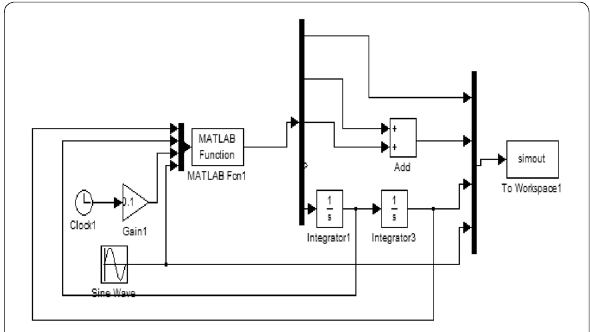
Figure 8 Schematic of piston rod